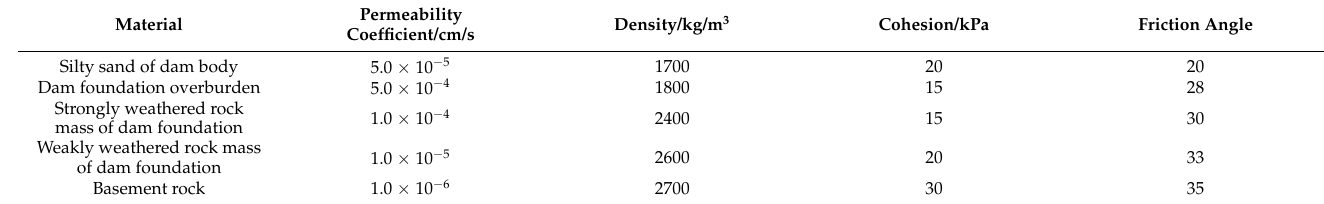
Figure 4. The most dangerous sliding surface of upstream dam slope reaches a stable state after sudden drop of water level. Table 1. Model calculation parameter.